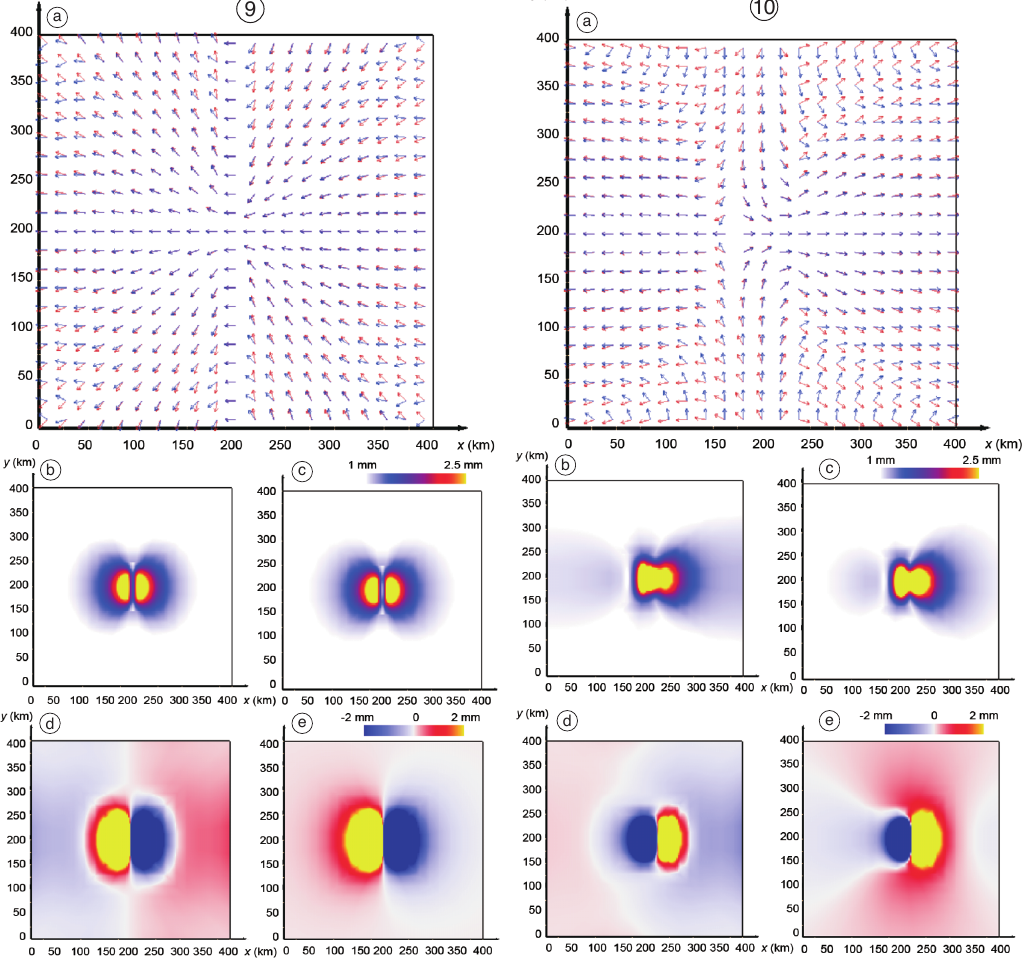
Fig. 9a-e. Same as fig. 3a-e but for a normal dip slip with δ = 90° and φ = 0° when the the bottom and lateral nodes are fixed in the direction perpendicular to the surface.